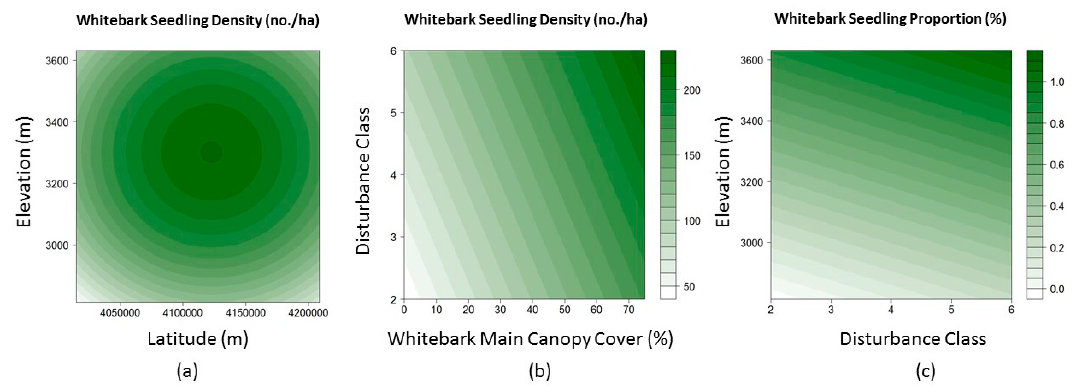
Figure 6. Filled contour plots displaying combined effects of explanatory variables in Study #1. Response variables shown at the top for ( a ) and ( b ) whitebark pine seedling density; ( c ) whitebark pine seedling proportion (%).